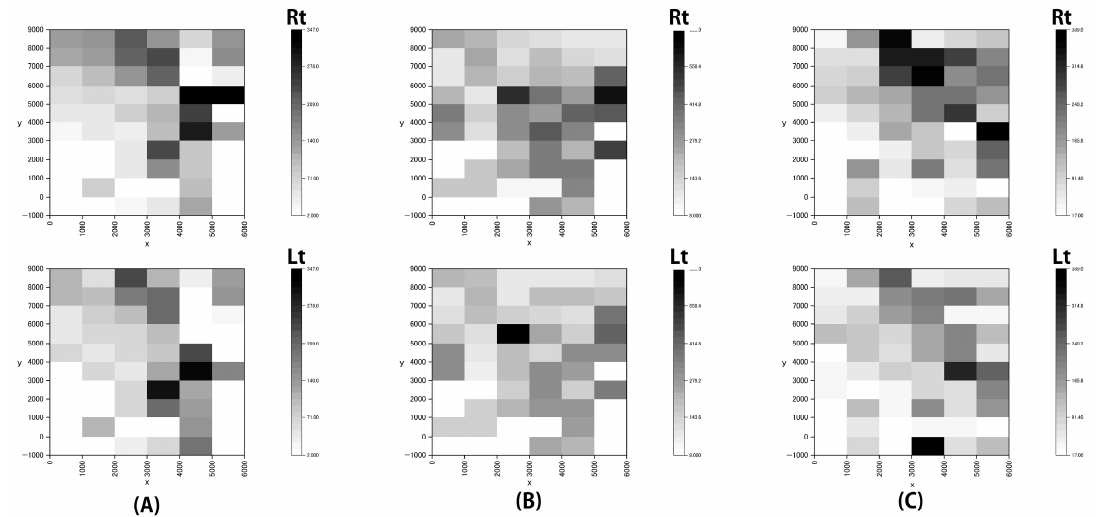
Figure 7. Heat maps. ( A – C ) indicate Experiments A, B, and C, respectively. The color of each area indicates the median dust concentration in that area (Rt, right-hand side and Lt, left-hand side). It was confirmed that the dust concentration near the humidifier with a 5% saline solution at (6600, 3600) was higher than those from the other areas. This was considered to reflect the dust emission in the experimental environment. In addition, it was confirmed that the dust concentration near the coordinate location ranges from (x = 2000–4000, y = 7000–9000) was high. In this experiment, the humidifier was installed at (0, 6400) and (6600, 3600) and acted as a dust source. This resulted in a gap in the heat map between the dust source and the areas with a high concentration of dust.